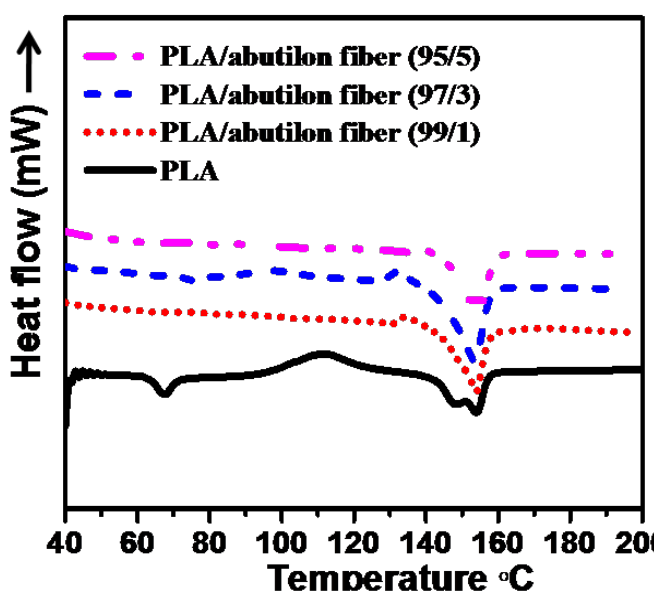
Figure 4. Differential scanning calorimetry of (PLA/abutilon fiber) composite. Figure 4. Di ff erential scanning calorimetry of (PLA / abutilon fiber)